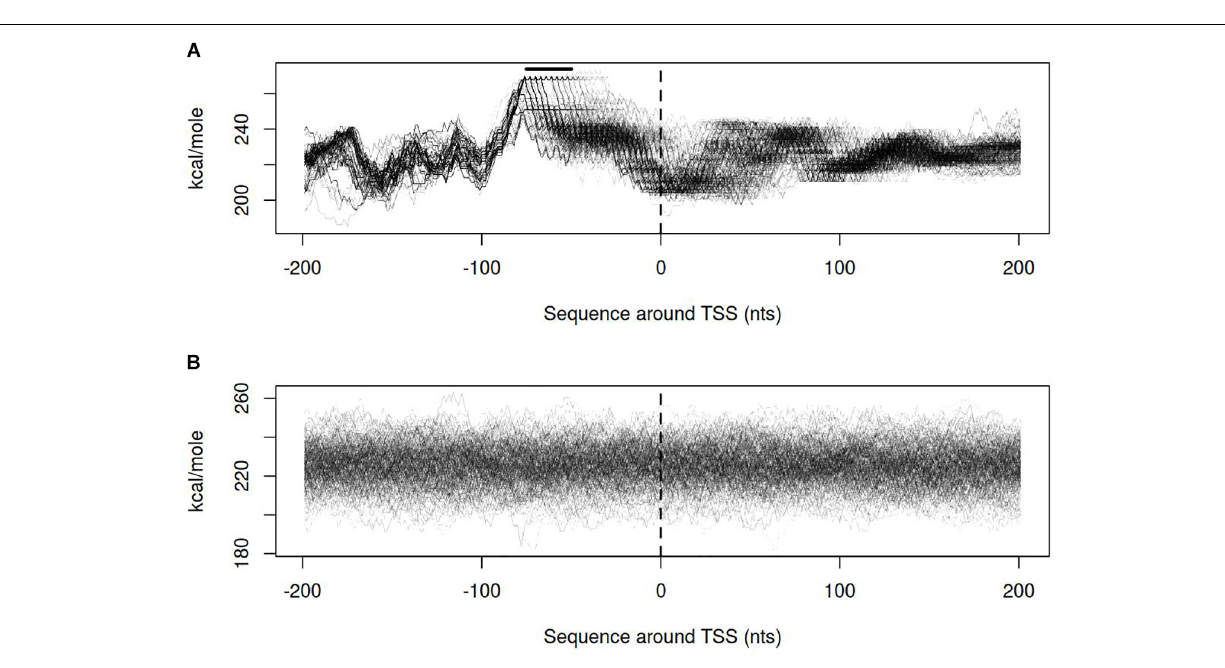
It is possible that M. gallisepticum has unique DNA binding proteins with the unknown spatial structure of the DNA binding region that standard annotation programs cannot identify. The